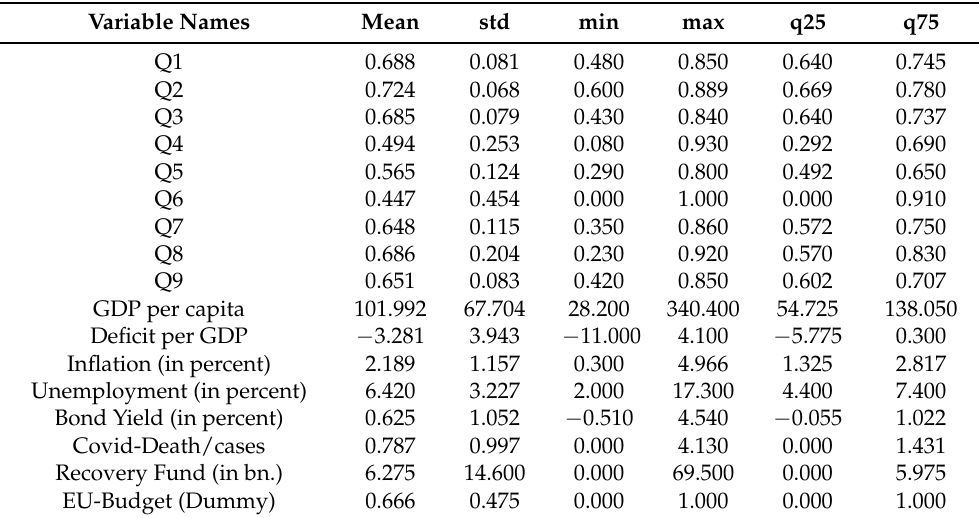
Table 1. Descriptive Statistics 2019 and